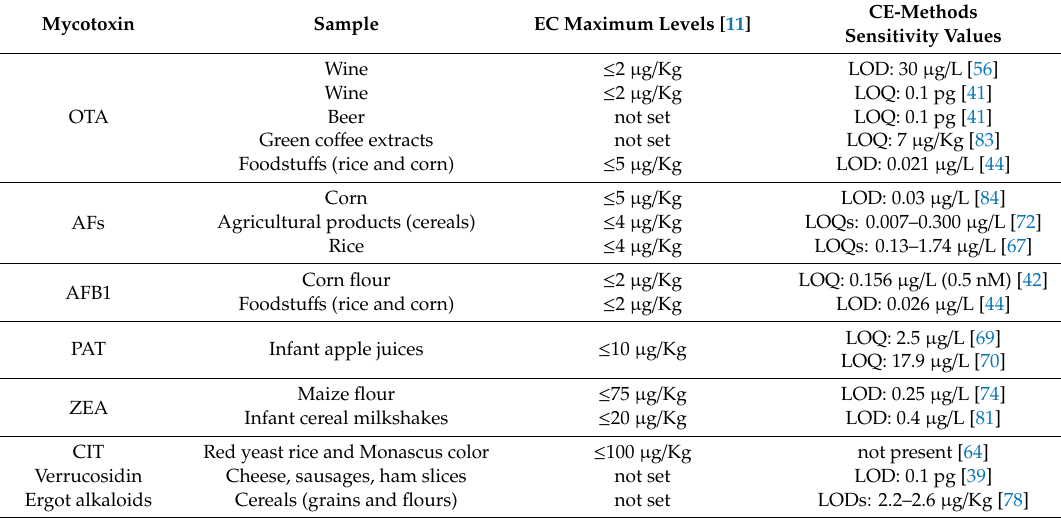
Table 3. Comparison between European Commission (EC) limits and sensitivity values obtained by CE methods reported in the present review for each mycotoxin and its relative food